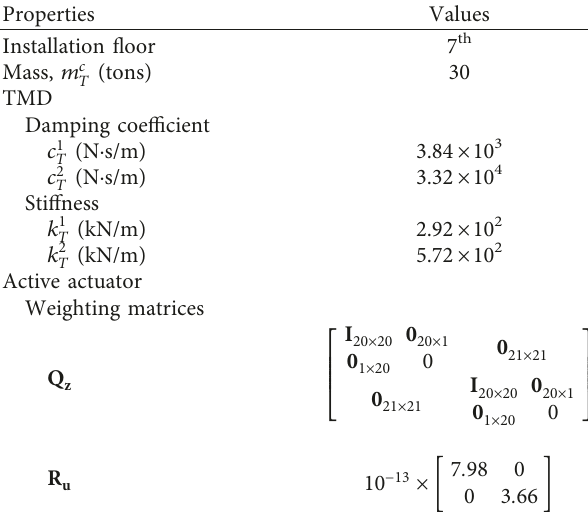
Table 2: IAS design results.